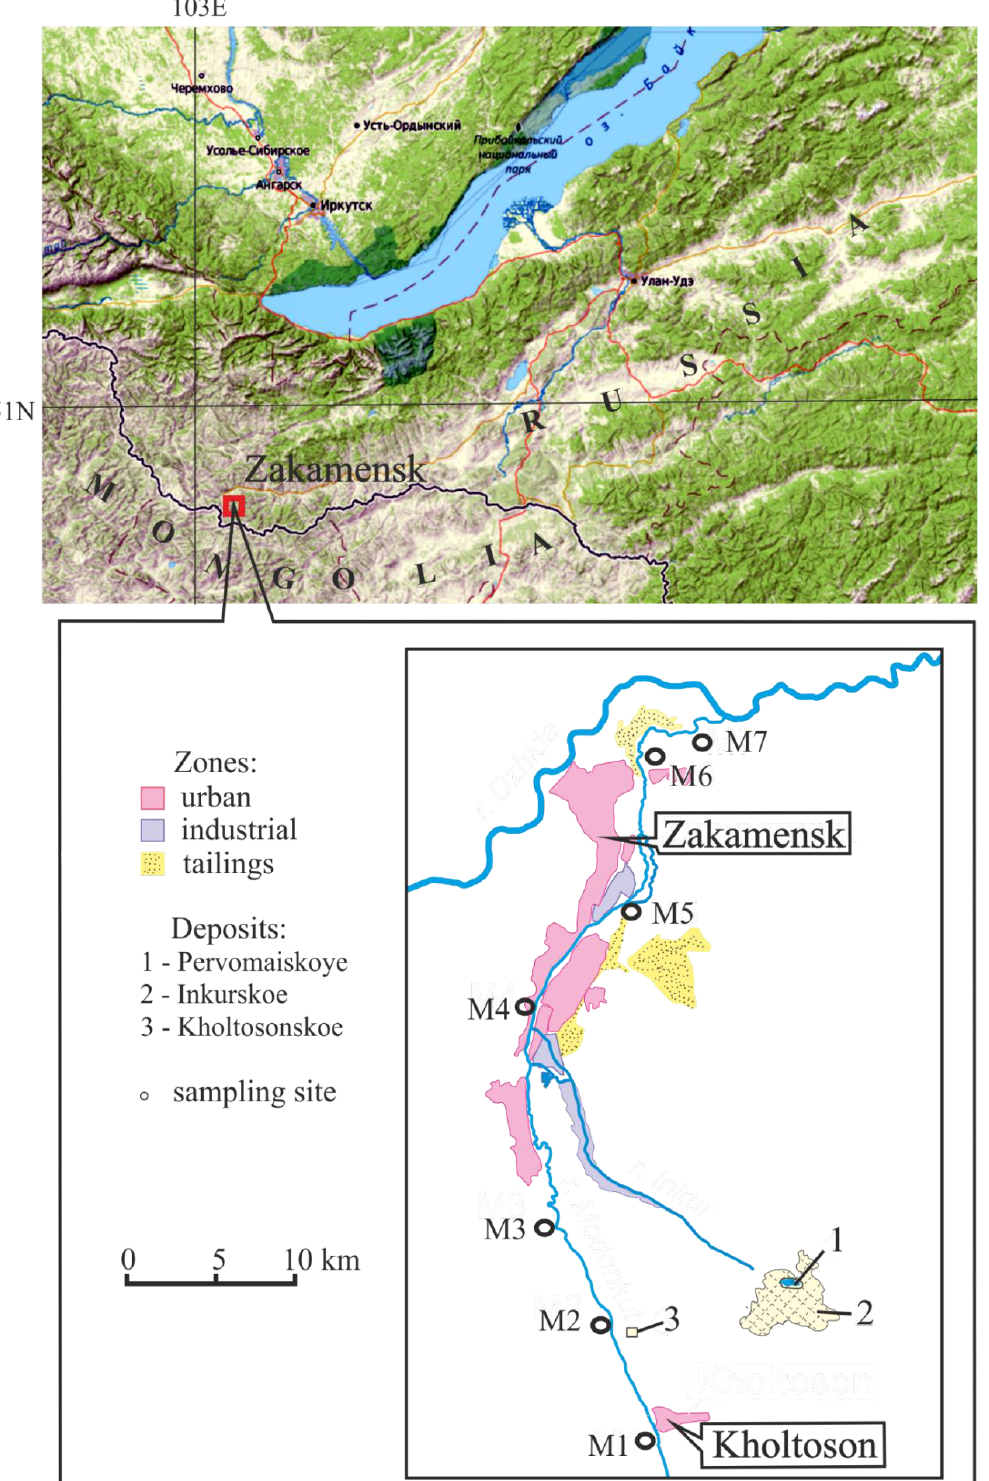
Figure 1. The scheme of the sampling sites.